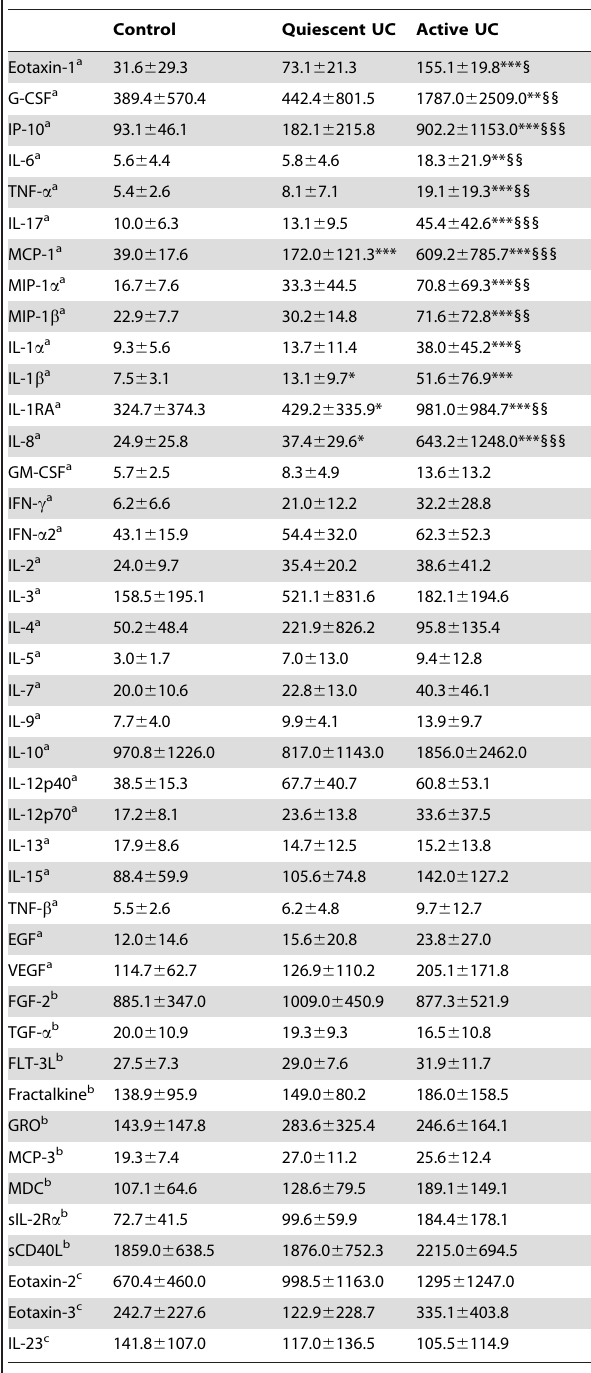
Table 3. Tissue cytokines/chemokines